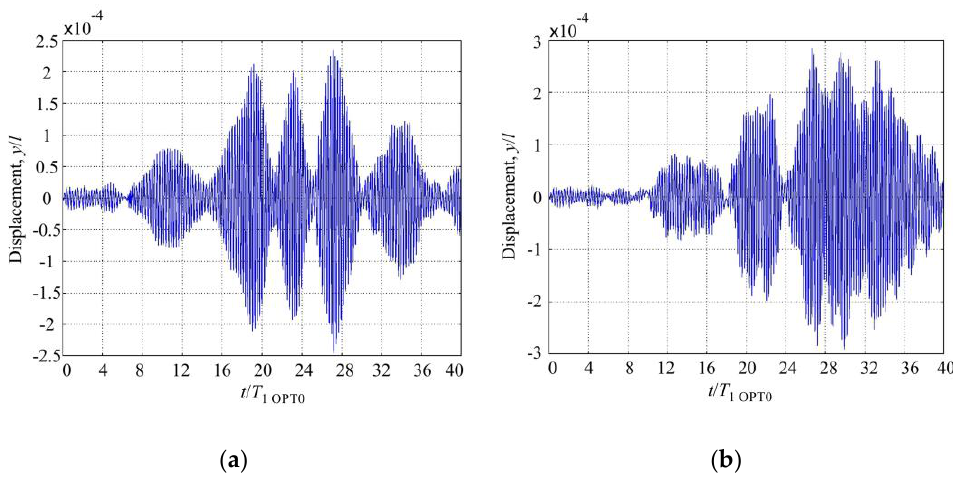
Figure 12. Response of the tip of randomly excited ( a ) microcantilever OPT 0 and ( b ) rational microcantilever OPT RAT.